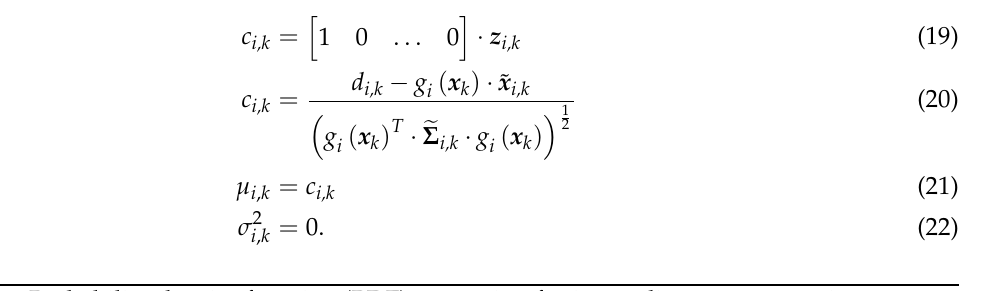
Algorithm 2: Probability density function (PDF) truncation for inequality state